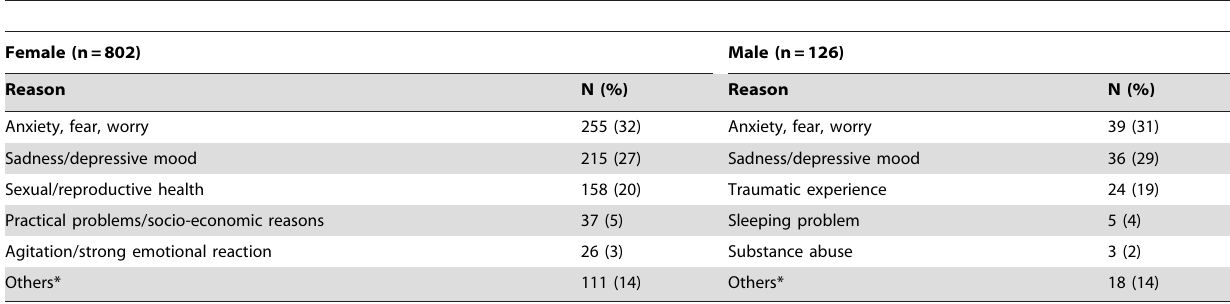
Table 4. The main presenting complaints while seeking mental health care according to standardized guidelines 3 stratified by gender, Timurgara district hospital, Pakistan (2012).